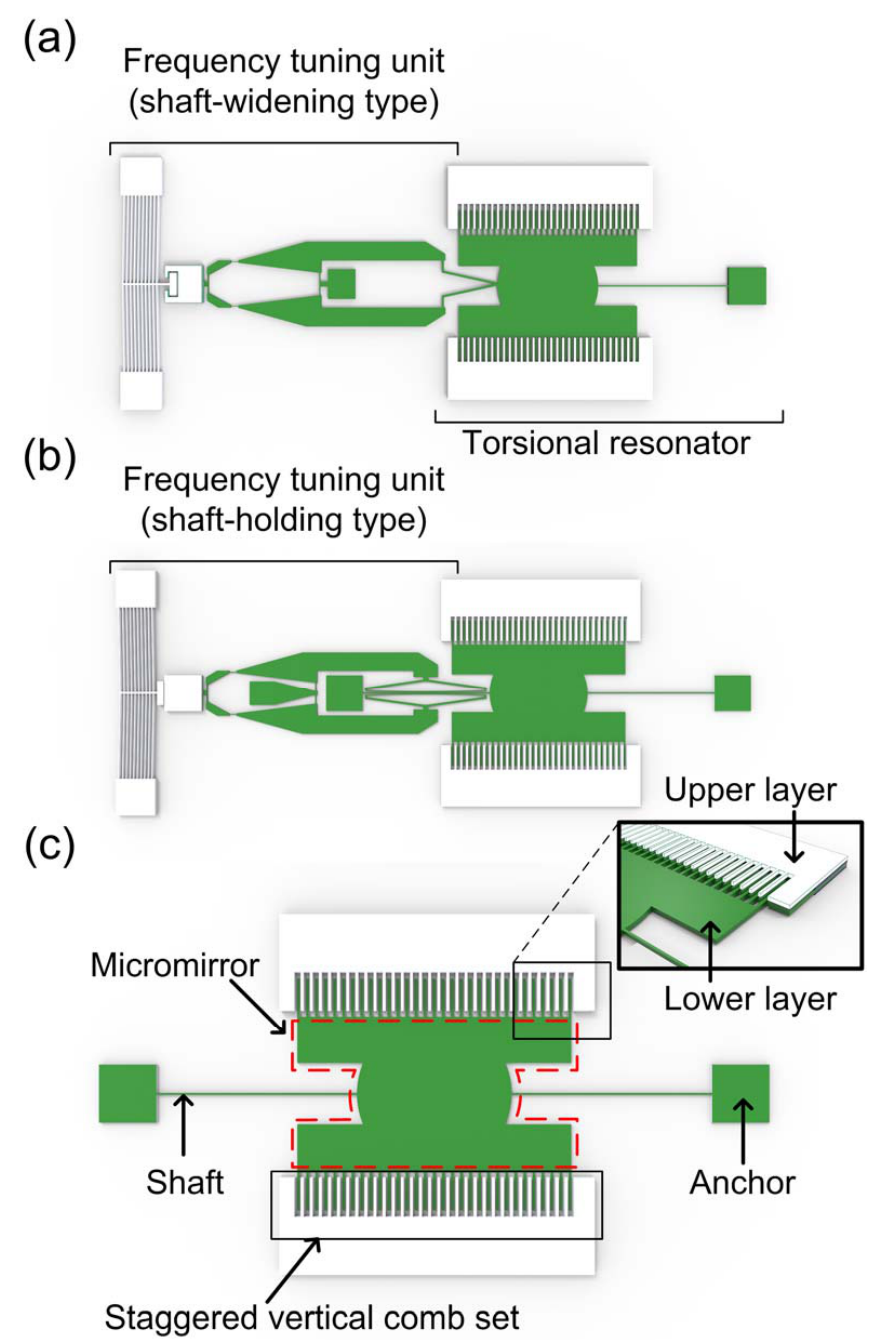
Figure 1. Schematics of frequency tuning units integrated with torsional resonators: ( a ) Shaft-widening type and ( b ) shaft-holding type. ( c ) Schematic layout of staggered vertical comb (SVC)-based torsional resonator. The micromirror is designed to optically read the torsional angle of the resonator. (Inset: close-up view of the SVC set defined on different silicon layers. Upper and lower layers are colored in white and green, respectively). Reproduced with permission from [26].